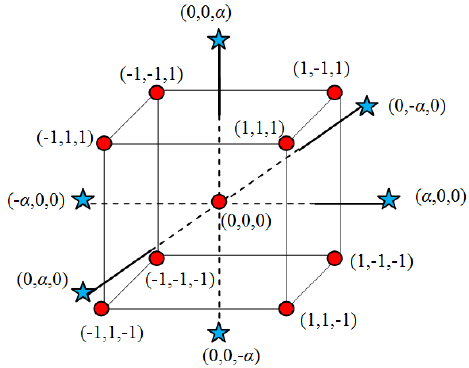
Figure 3. Distribution of three variables’ central composite design test points.